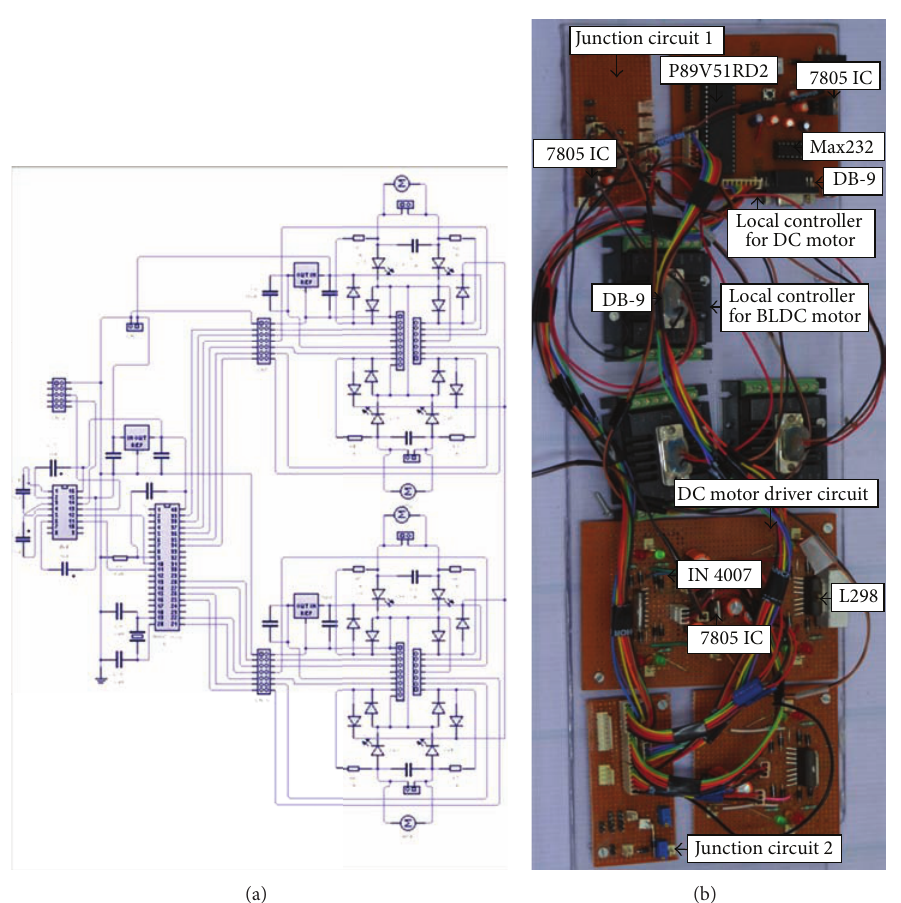
Figure 16: (a) Schematic design of interfacing circuit between microcontroller and motor driver. (b) Developed interfacing circuit of